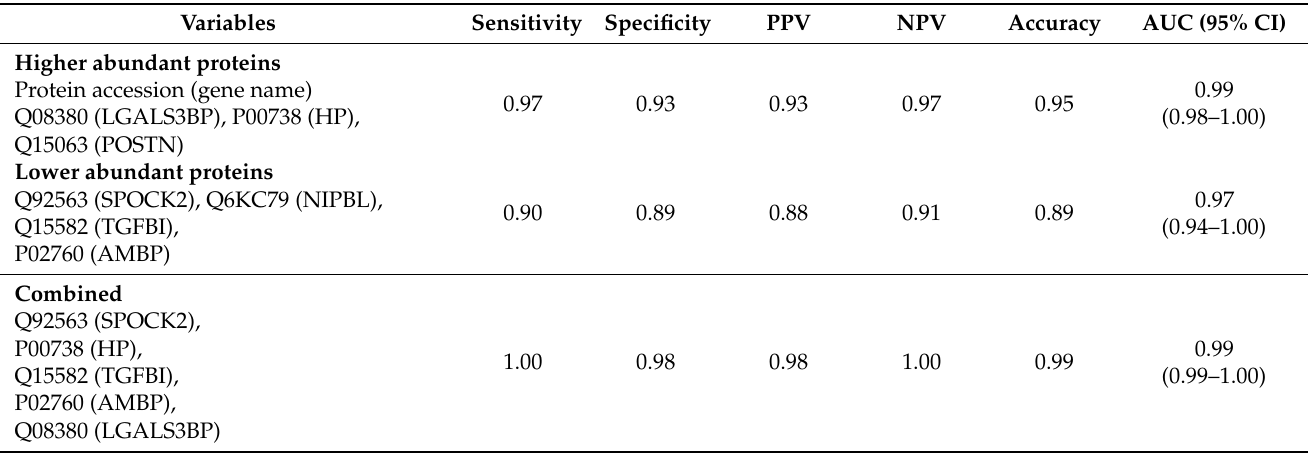
Table 3. Diagnostic accuracy of biomarker panels of proteins identified by Random Forest supervised machine learning algorithm. Classifiers were trained using the proteins identified in Table 2. Proteins from the two datasets were analyzed separately and in combination. The proteins analyzed were: Q08380: galectin-3-binding protein; P00738: haptoglobin; Q15063: periostin. Q92563: